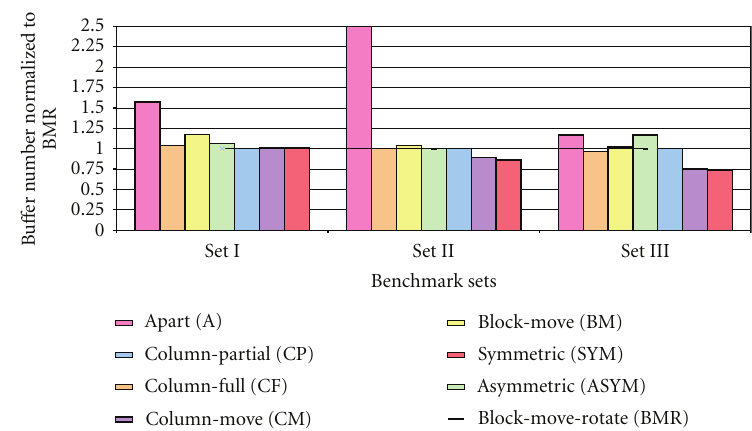
Figure 19: Generalized bu ff er comparison results of mesh- and tree-based